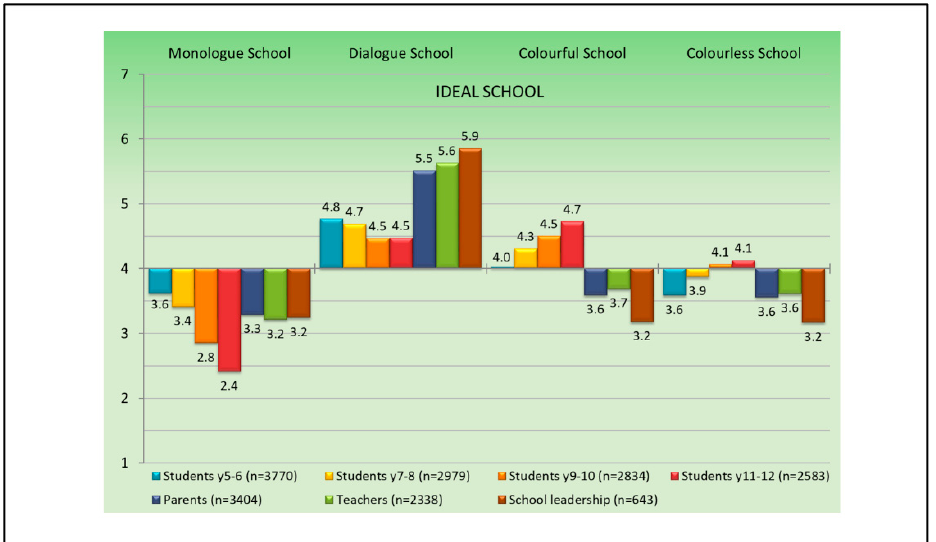
Figure 5. Victoria Scale results among all respondent groups in Brisbane.